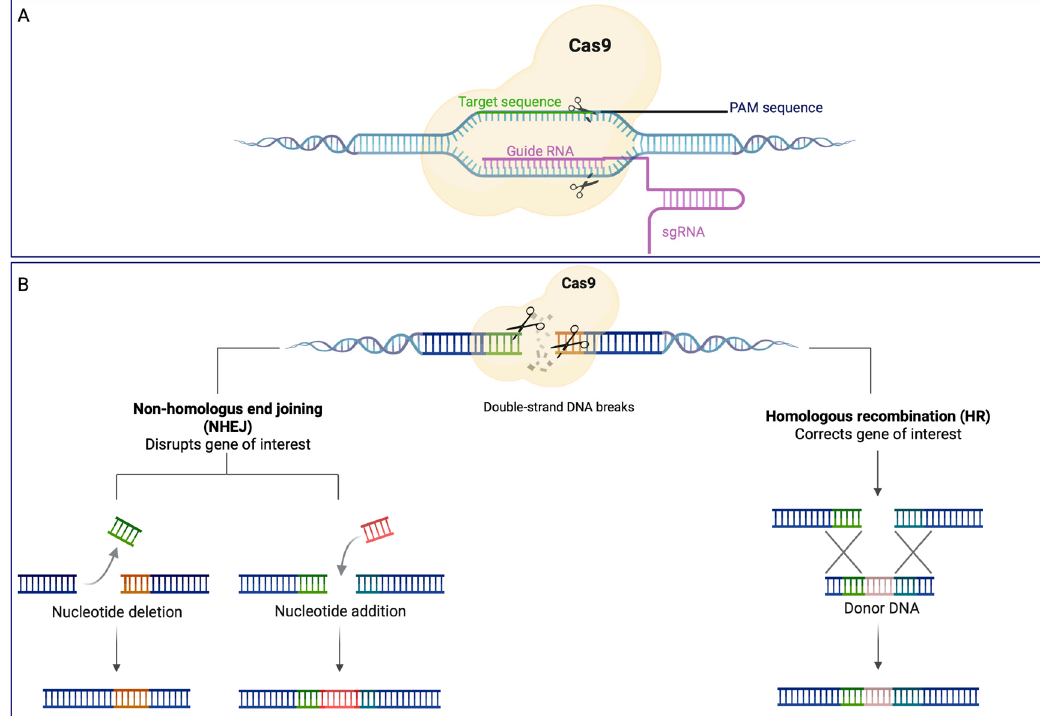
Figure 2. Cas9 endonuclease recruiting for target recognition using a single chimeric RNA ( A ) and genome editing ( B ). ( A ) When the targeted sequence (green) is immediately followed by a PAM sequence, a single chimeric guide RNA (violet) guides the active Cas9 endonuclease (light yellow) to cleave-site-specific DNA; ( B ) once double strand DNA breaks are performed, cells activate error- prone non homologous end-joining (NHEJ) repair pathways to fix the damage by adding random tiny insertions (red) or deletions at the cut spot; when a homologous DNA template is available, cells can repair their DNA through a process known as homologous recombination (HR), which leads to genomic knock-in (light brown) at the exact cut region. This figure was created with BioRender.com (accessed on 7 December 2022).